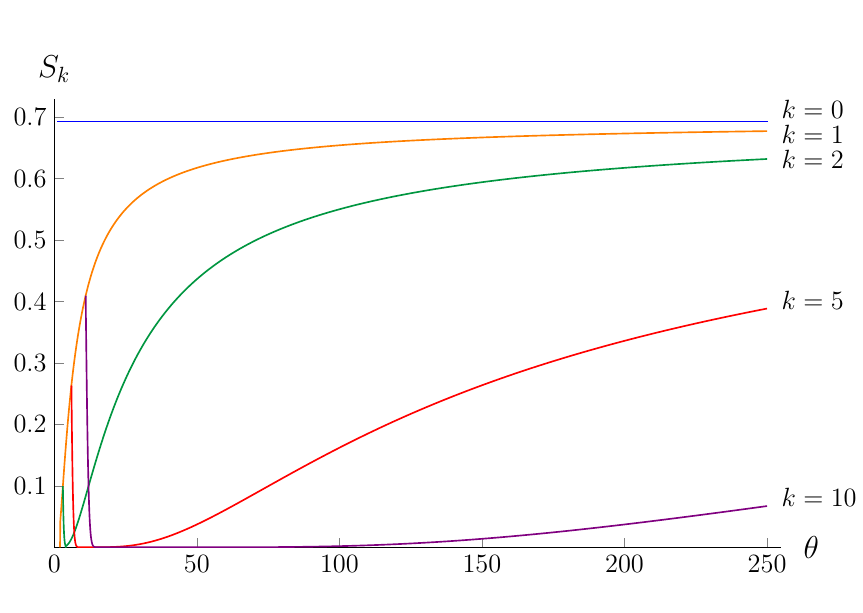
Figure 4. Entanglement entropy as a function of (cid:18) for some (cid:12)xed values of k using the analytical approximation found in (3.5).